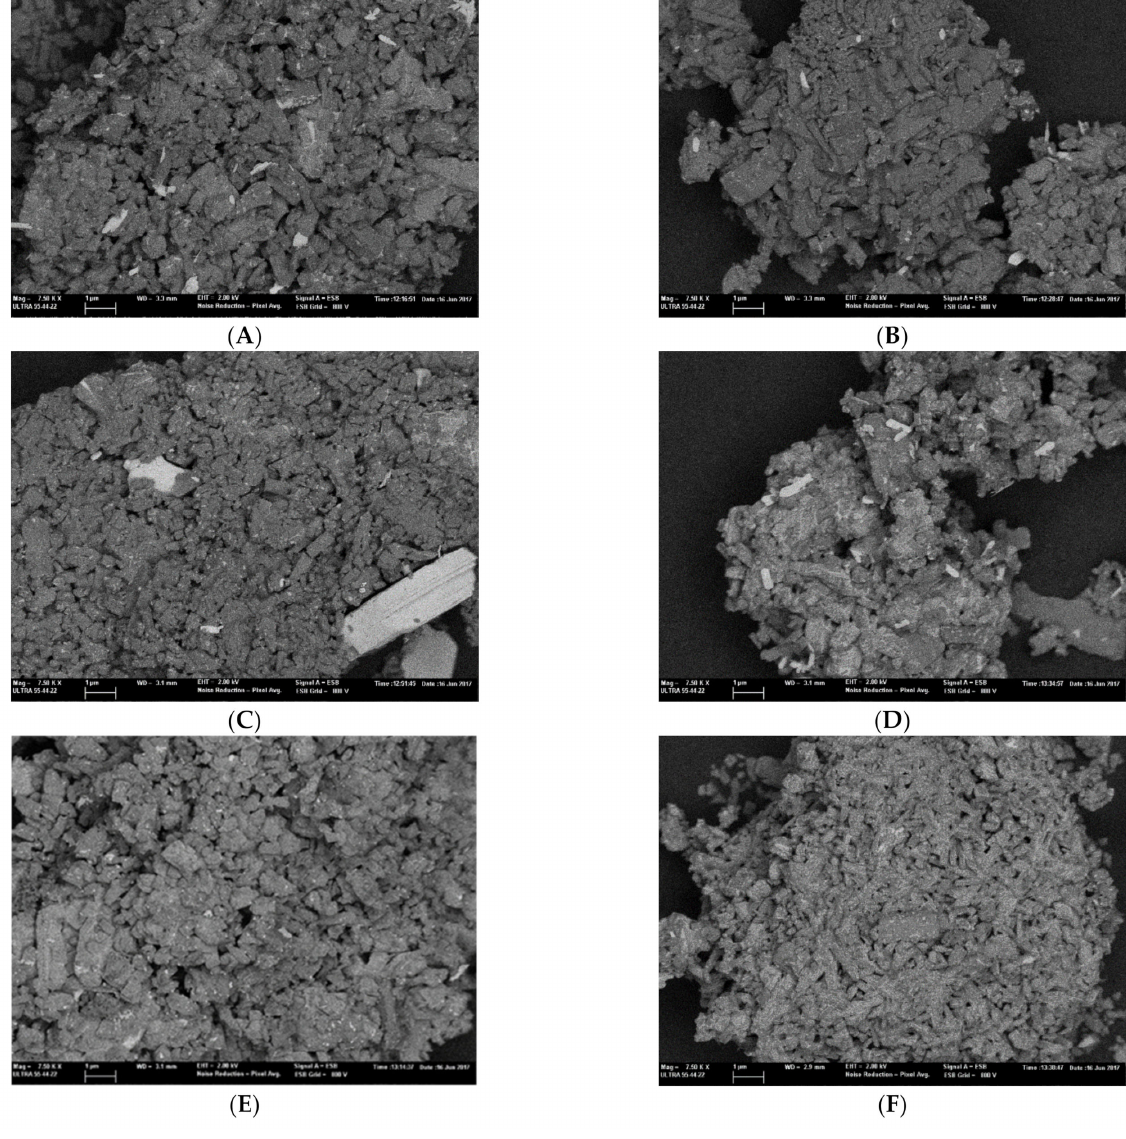
Figure 2. FESEM images of the Mo/ZSM-5 catalysts by a field emission scanning electron microscopy employing a backscatter electron detector (BSE): ( A ) MoZ5-IW-SC, ( B ) MoZ5-IW-DC, ( C ) MoZ5-SSR-SC, ( D ) MoZ5-SSR-DC, ( E ) MoZ5- SSR-SC-N2, ( F ) MoZ5-SSR-DC-N2. Table 2. Acidic properties of the Mo/ZSM-5